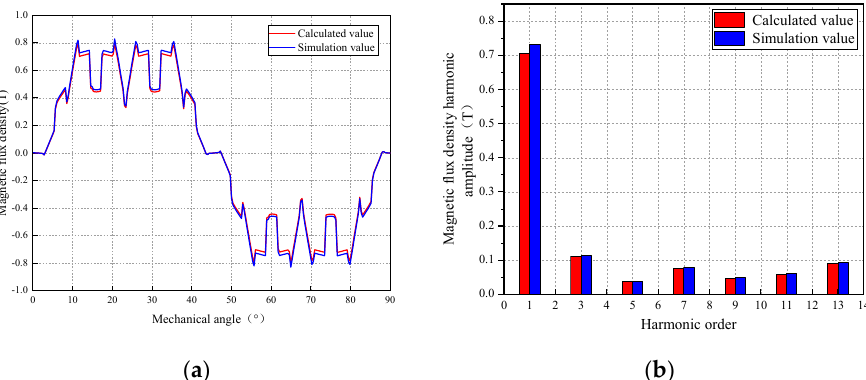
Figure 8. Comparison diagram of the magnetic flux density at the middle of the air gap: ( a ) Magnetic flux density waveform; ( b ) Harmonic amplitude of magnetic flux density.